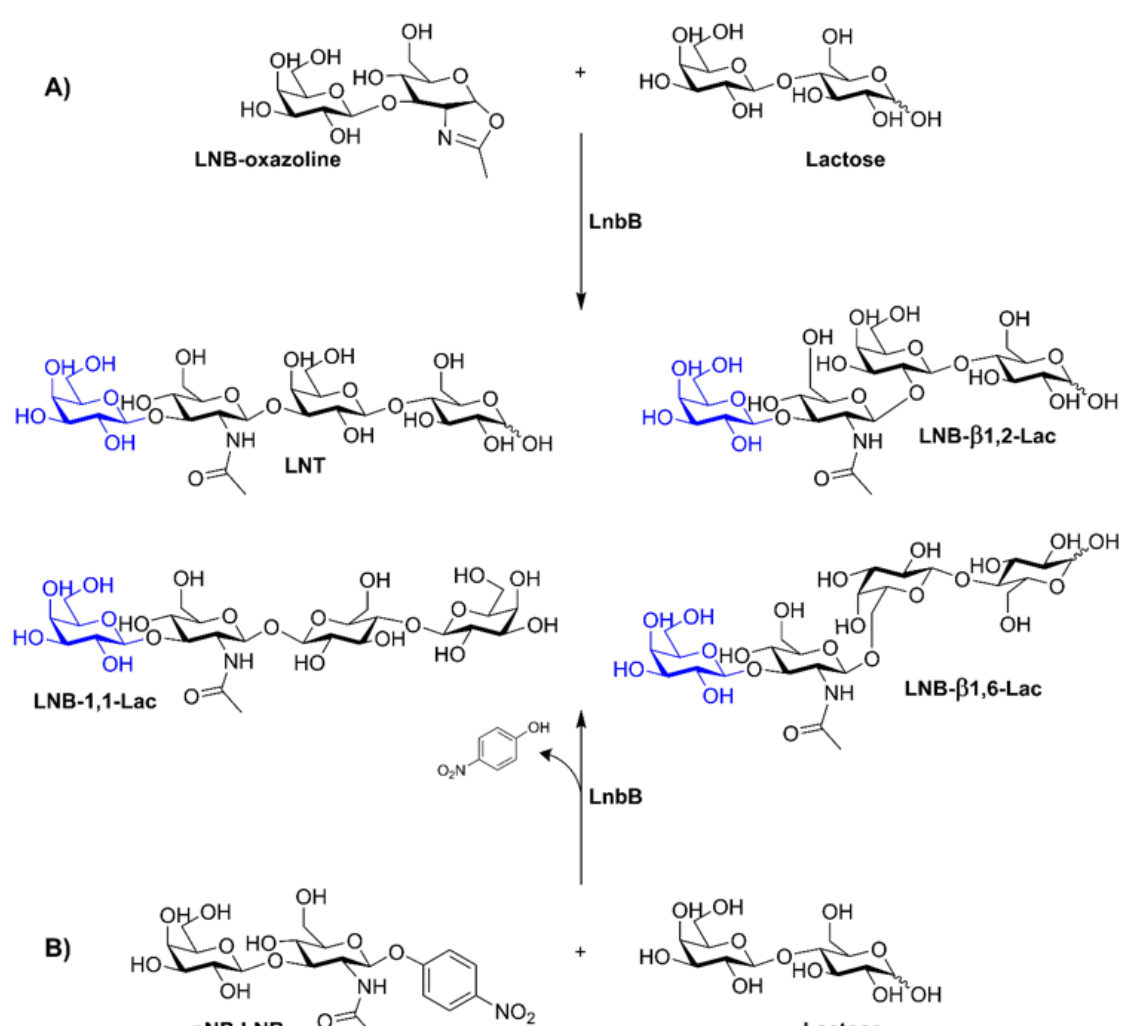
Figure 1. Transglycosylation reactions catalyzed by LnbB in the current work with LNB-oxazoline ( A ) or pNP-LNB ( B ) as donor substrate and lactose as acceptor substrate. All reactions take place in competition with substrate and product hydrolysis (Figure S1). The terminal Gal residue (blue) was subsequently removed by the GH35 β 1,3-galactosidase BgaC from Bacillus circulans ATCC 31382 (Figure S2), and the resulting LNT2 (GlcNAc- β 1,3-Gal- β 1,4-Glc) isomers were compared to their chemically synthesized counterparts (Schemes S1–S3 ). LNT (Gal- β 1,3-GlcNAc- β 1,3-Gal- β 1,4-Glc) isomers were also subjected to NaBH 4 -catalyzed reduction to confirm the presence of a LNB-1,1-Lac